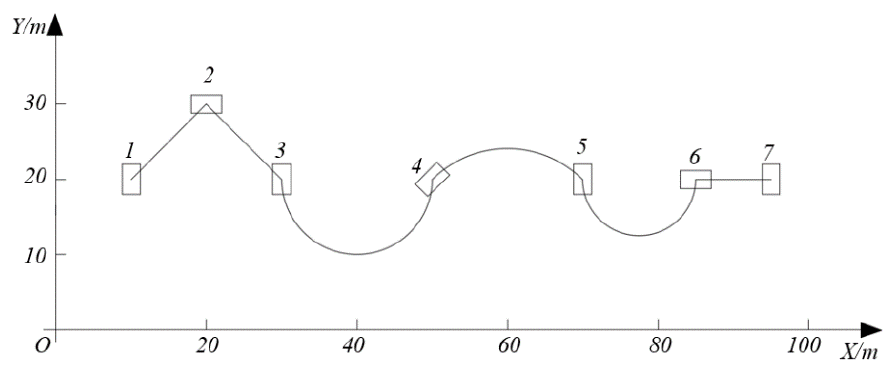
Figure 11. Experimental path schematic.